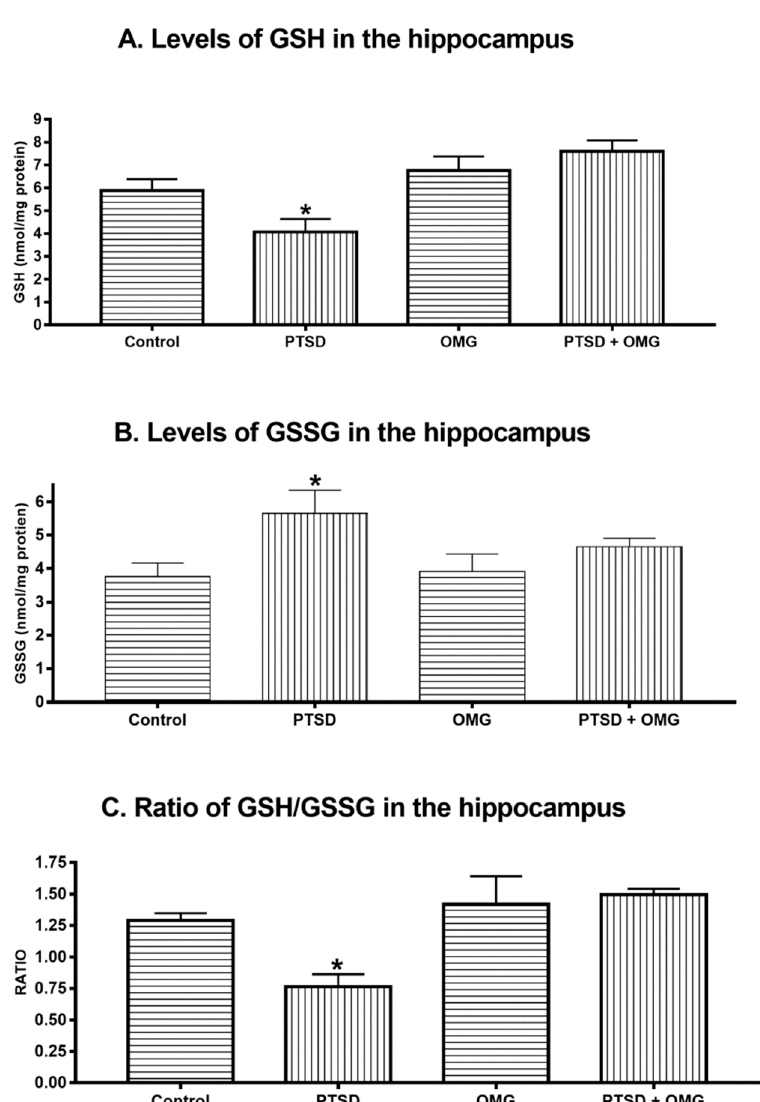
Figure 3. Effect of omga-3 and/or SPS model of PTSD on the levels of glutathione (GSH), oxidized glutathione (GSSG), and GSH/GSSG ratio in the hippocampus. ( A ) Hippocampal GSH levels, ( B ) hippocampal GSSG levels, and ( C ) hippocampal GSH/GSSG ratio. Among control, post-traumatic stress disorder (PTSD), omega-3 treated animals (OMG), and PTSD treated with OMG (PTSD + OMG) groups. * Indicate significant difference relative to other groups ( p < 0.05). Each point is the mean ± SEM of 15 rats.